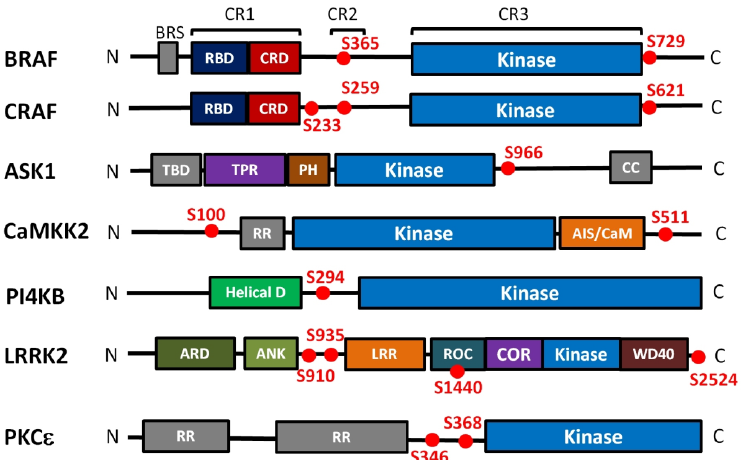
Figure 2. Domain structure and positions of 14-3-3 binding motifs of kinases regulated in the 14-3-3-dependent manner. Kinase domains are shown in blue, the 14-3-3 binding sites are shown as red dots. BRS, B-RAF specific domain; RBD, Ras binding domain; CRD, cysteine rich domain; TBD, TRX-binding domain; TPR, tetratricopeptide repeats domain; PH, pleckstrin homology domain; CC, coiled-coil region; RR, N-terminal regulatory site; AIS/CaM, autoinhibitory segment/CaM-binding domain; Helical, helical domain; ARD, armadillo repeat; ANK, ankyrin repeat; LRR, leucine-rich repeat; ROC, Ras of the complex GTPase domain; COR, C-terminal of ROC; WD40, WD40 or beta-transducin repeat. The kinases di ff er in their length and they are not shown on the same